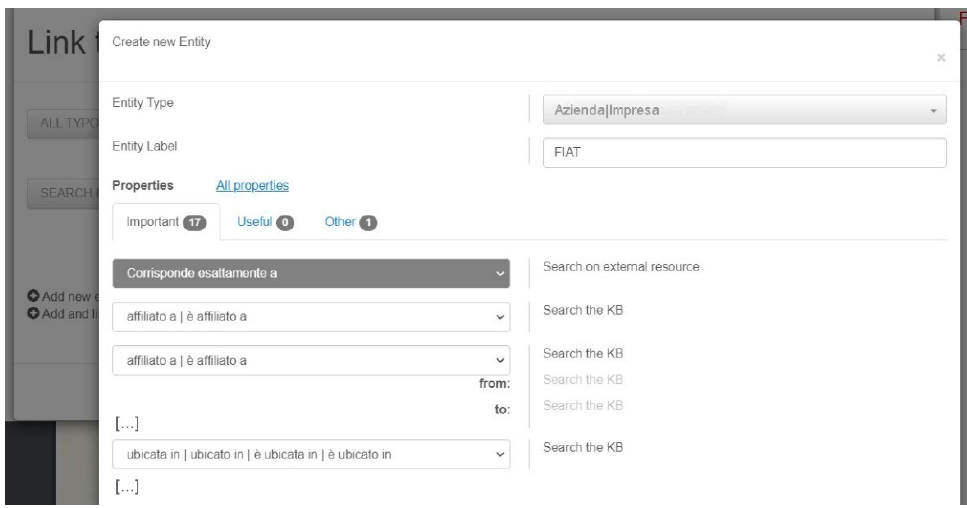
Figure 4. Part of the form for the characterization of an entity (e.g., a company).